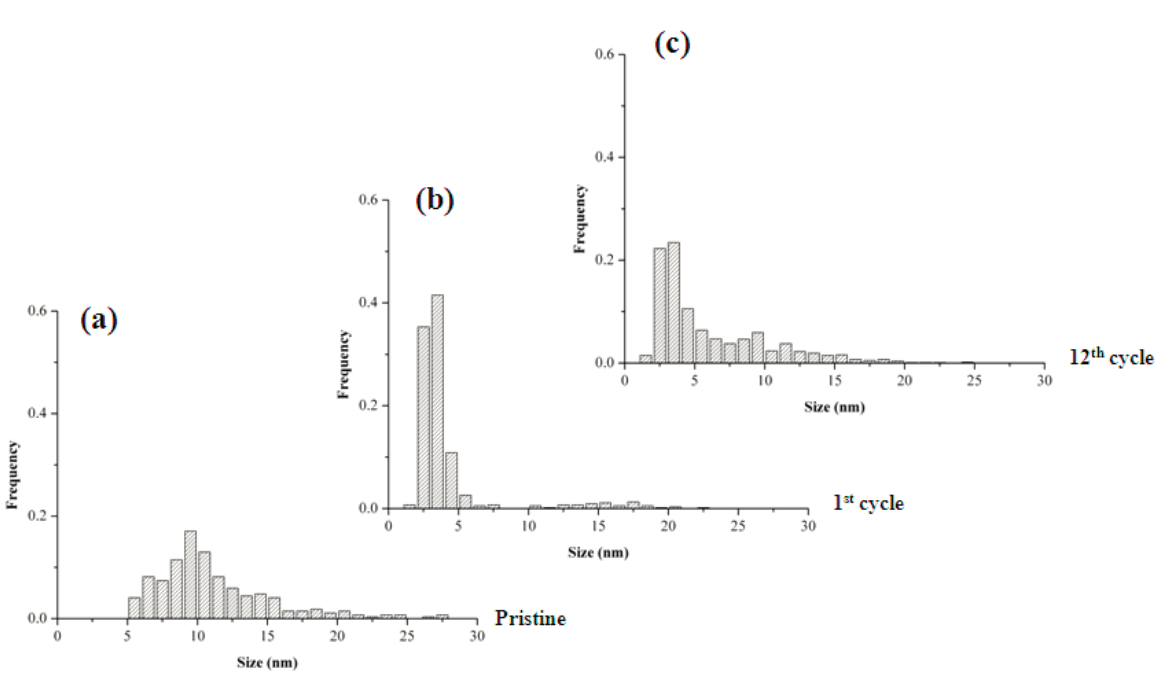
Figure 9. Pd NPs particle size distributionsof Pd-pol ( a ) before; ( b ) after the first cycle and ( c ) after the twelfth cycle of nitrobenzene reduction with NaBH 4